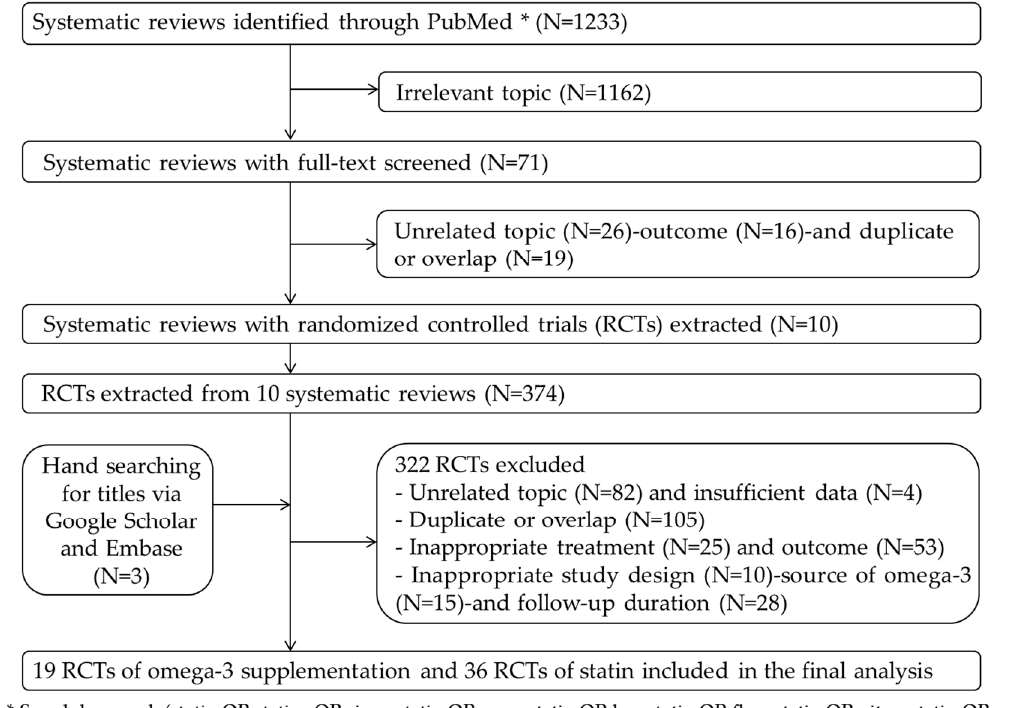
Figure 1. Flowchart of search strategy and study selection.